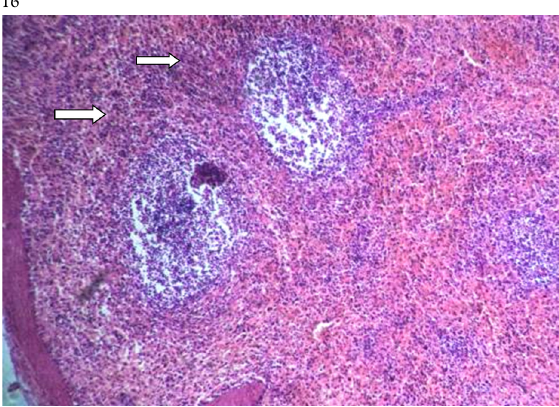
Fig. 10. Ileum, showing lymphoid depletion of the Payer’s patches (star) and severe glandular epithelial cell necrosis (arrow) H&E × 100 (Ezeasor,